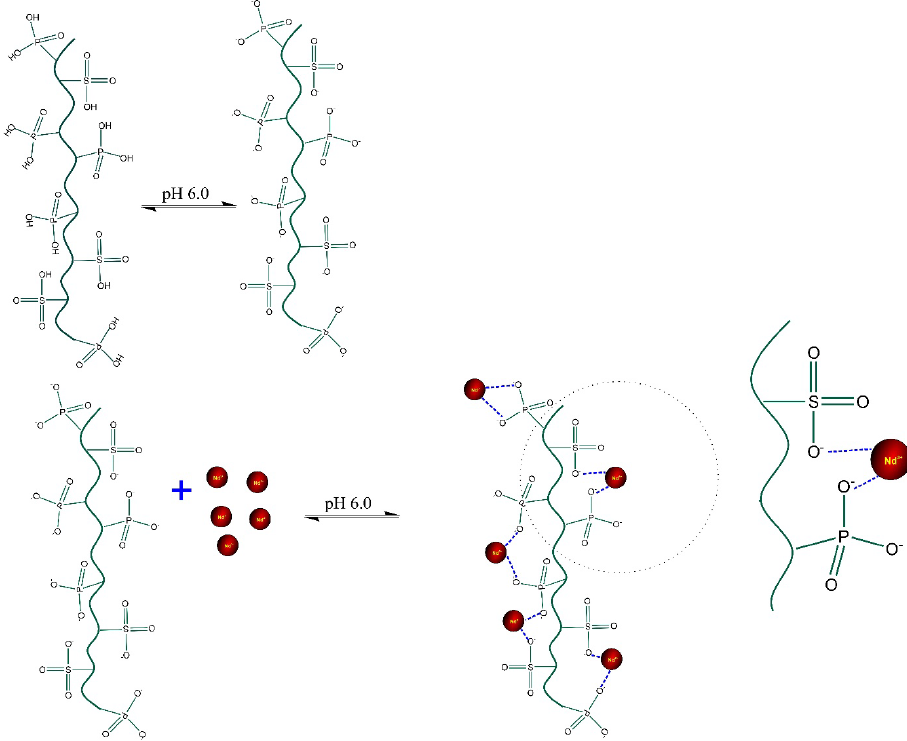
Figure 7. Proposed mechanism of adsorption of Nd 3+ by both LEB-18 and LEB-52 Spirulina platensis biosorbents.